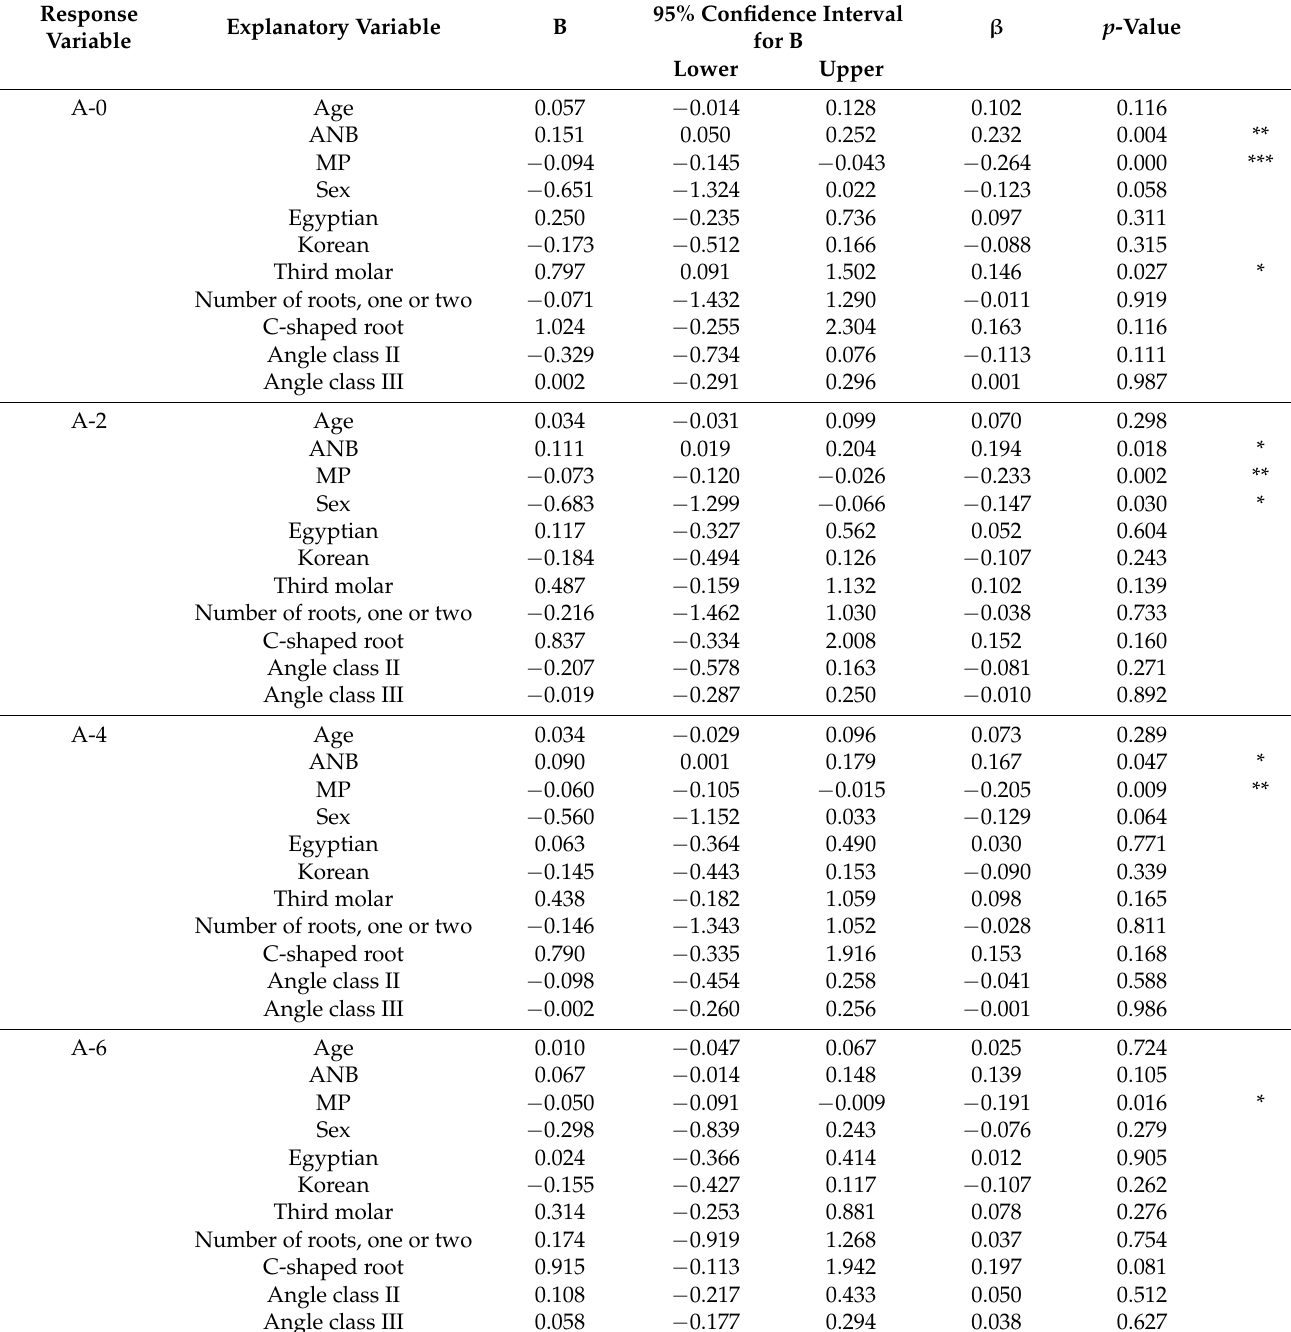
Table 3. Results of multiple regression analysis (sagittal